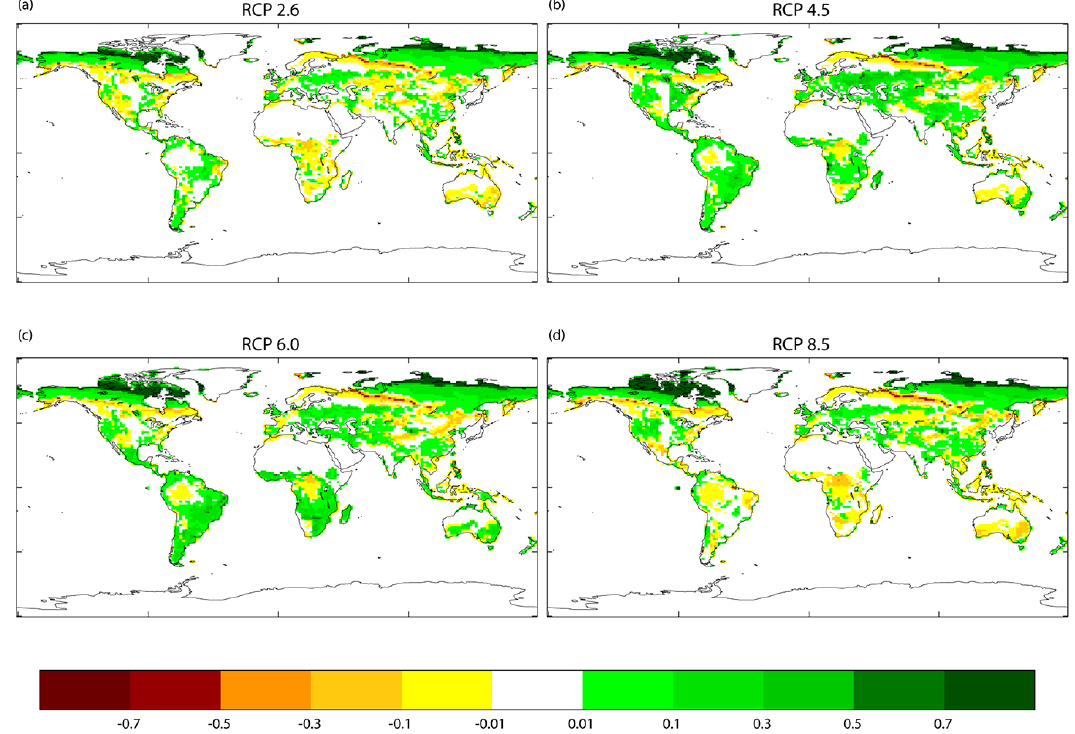
Figure 8. Changes in fractional cover of shrub by 2070–2099 relative to 1971–2000 simulated by HadGEM2-ES driven by scenarios of greenhouse gas and aerosol concentrations and land use following (a) RCP2.6 (b) RCP4.5 (c) RCP6.0 and (d) RCP8.5.